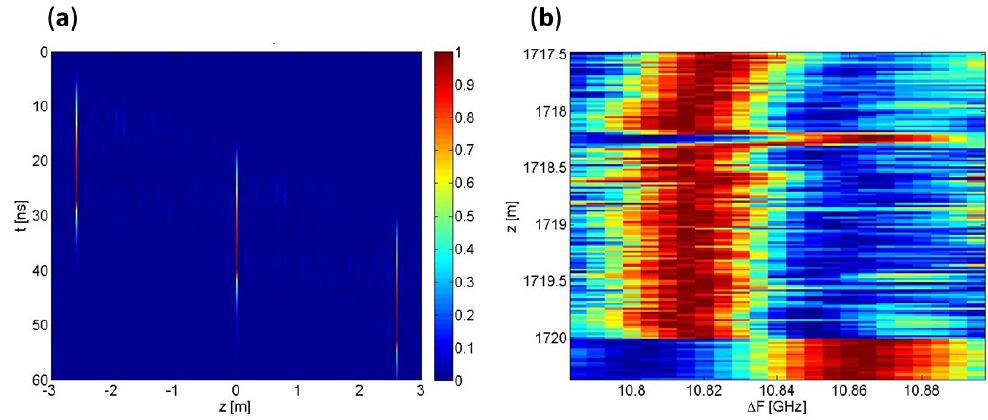
Figure 4. Phase-coded B-OCDA with overlaid pulse modulation of the pump wave. ( a ) Calculated normalized magnitude of the stimulated acoustic wave density fluctuations as a function of time and position along 6 m of fiber. Both pump and signal waves are co-modulated by a perfect Golomb phase code that is 127 bits long with a symbol duration of 200 ps. The pump wave is further modulated by a single amplitude pulse of 26 ns duration. The acoustic wave is confined to discrete and periodic narrow correlation peaks. Acoustic waves at peak locations are stimulated sequentially, one after another, with no temporal overlap. Reproduced with permission from [22], Optical Society of America, 2014. ( b ) Measured normalized Brillouin gain as a function of correlation peak position and frequency offset between the pump and signal waves. The fiber under test was over 1600 m long. Phase-coded B-OCDA with an overlaid pump pulse was performed with a spatial resolution of 2 cm. All 80,000 resolution points were successfully addressed. The gain map shows a magnified view of 3 m towards the far end of the fiber, containing a few-centimeters-long hot spot. The heated region is clearly identified in the measurements. Reproduced with permission from [42], SPIE, 2014.